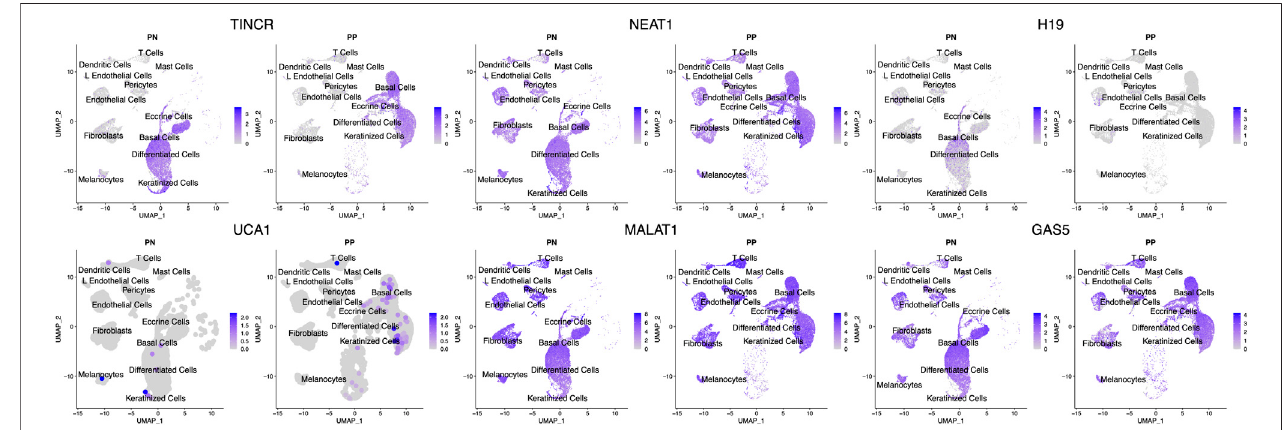
FIGURE2| ExpressionoflncRNAsacrossdifferentcelltypes.UMAPofthescRNA-seqdatahighlightsthecelltypespeci fi c/sharedexpressionpro fi lesfordifferent lncRNAs.TheintensityofbluecorrespondstotheexpressionlevelofthelncRNAsineachcell.Thecelltypeannotationslabelthecellclustersnearby.PPdenoteslesional psoriasis skin, while PN denotes nonlesional psoriasis